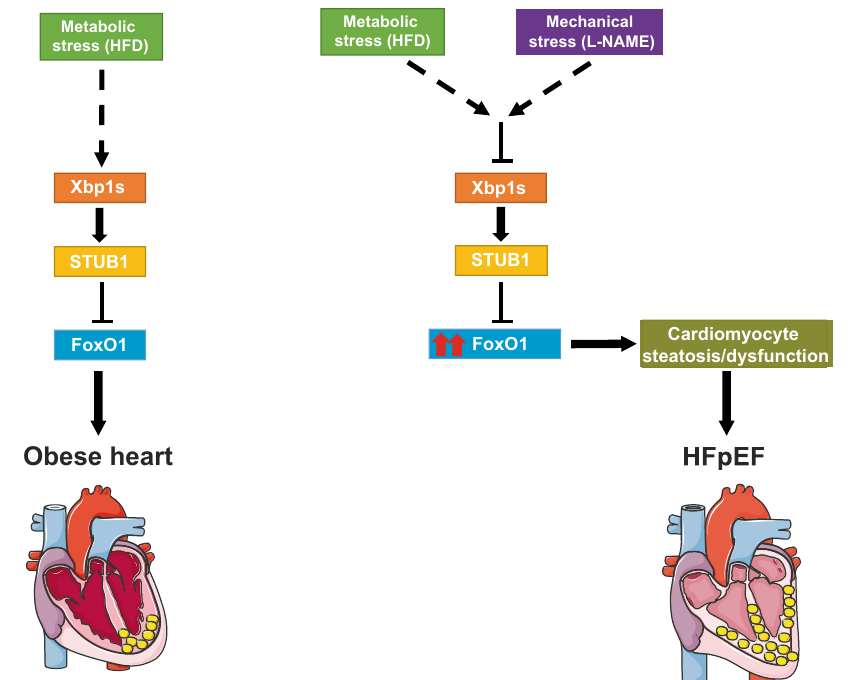
Fig. 6 Proposed model. Schematic depicting a mechanistic model of Xbp1s-STUB1-FoxO1 axis in